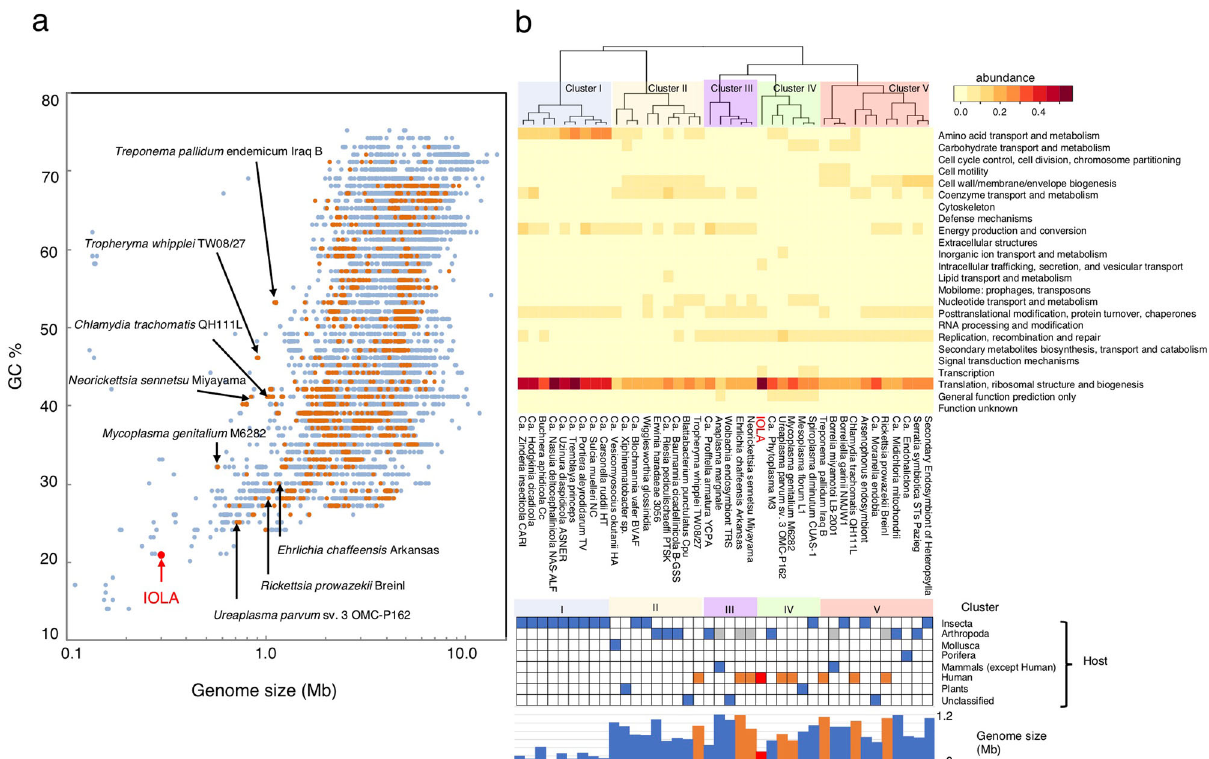
Fig. 5 Comparison of genomic features of bacteria with extremely small genomes and low GC contents. a Scatter plot based on the genome sizes and GC contents of 9871 bacteria. Orange dots indicate bacteria with host names registered as “ Homo sapiens ” . IOLA is indicated by a red dot. b COG functional category proportions, hosts, and genome sizes of the host-associated bacteria with small genomes are shown. The 39 bacterial species with the smallest genome size in each genus were selected from 265 host-associated bacteria with genome sizes less than 1.2 Mb. The major clusters based on the heatmap of COG functional category proportions are colored. All information, such as the number of genes in each COG functional category, host names, genome sizes, and ecosystems, was collected from the JGI IMG database (http://img.jgi.doe.gov). The arrows in a show the human-associated bacteria selected in b . The generally known nonhuman vectors or hosts of the human-associated bacteria are shown as gray boxes in “ host category ”